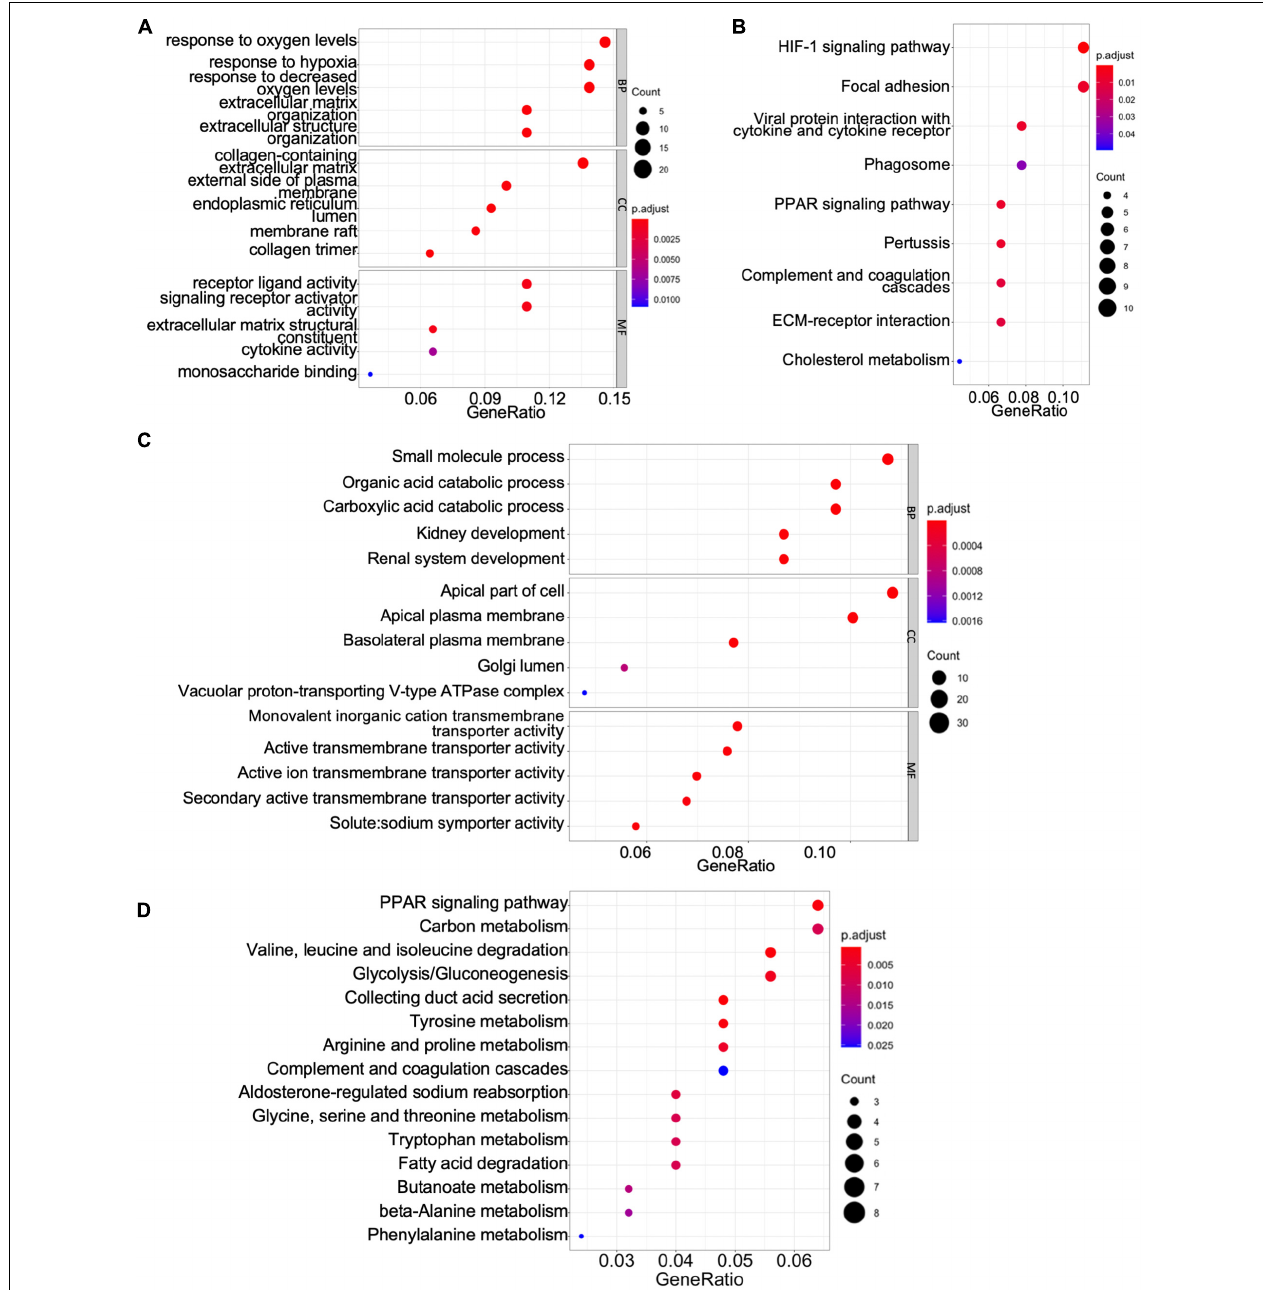
FIGURE 2 | Gene Ontology (GO) term enrichment and Kyoto Encyclopedia of Genes and Genomes (KEGG) pathway analyses of shared differentially expressed genes. (A,C) The GO terms of the biological process, cellular component (CC), and molecular function (MF) for upregulated (A) and downregulated (C) differentially expressed genes. (B,D) The KEGG pathway analyses of upregulated (B) and downregulated (D) differentially expressed